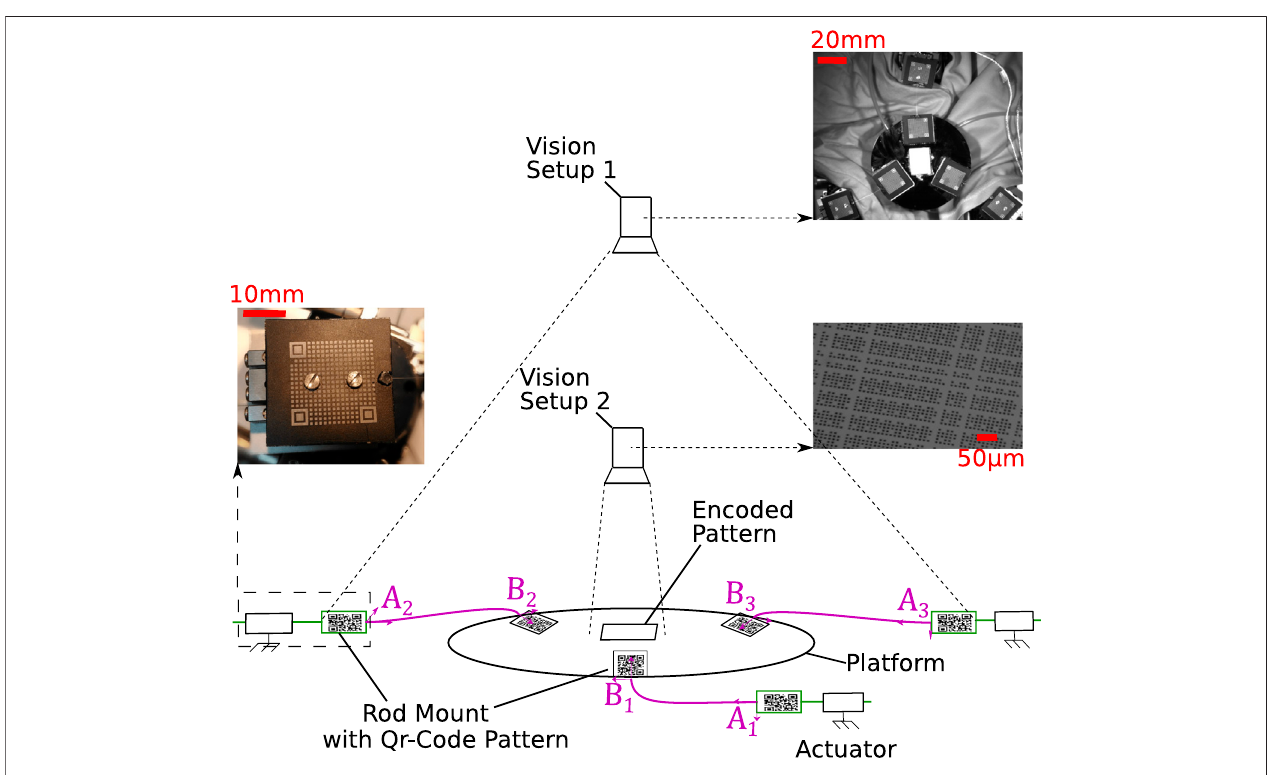
FIGURE 4 | Scheme of the experimental setup with the several measurement vision